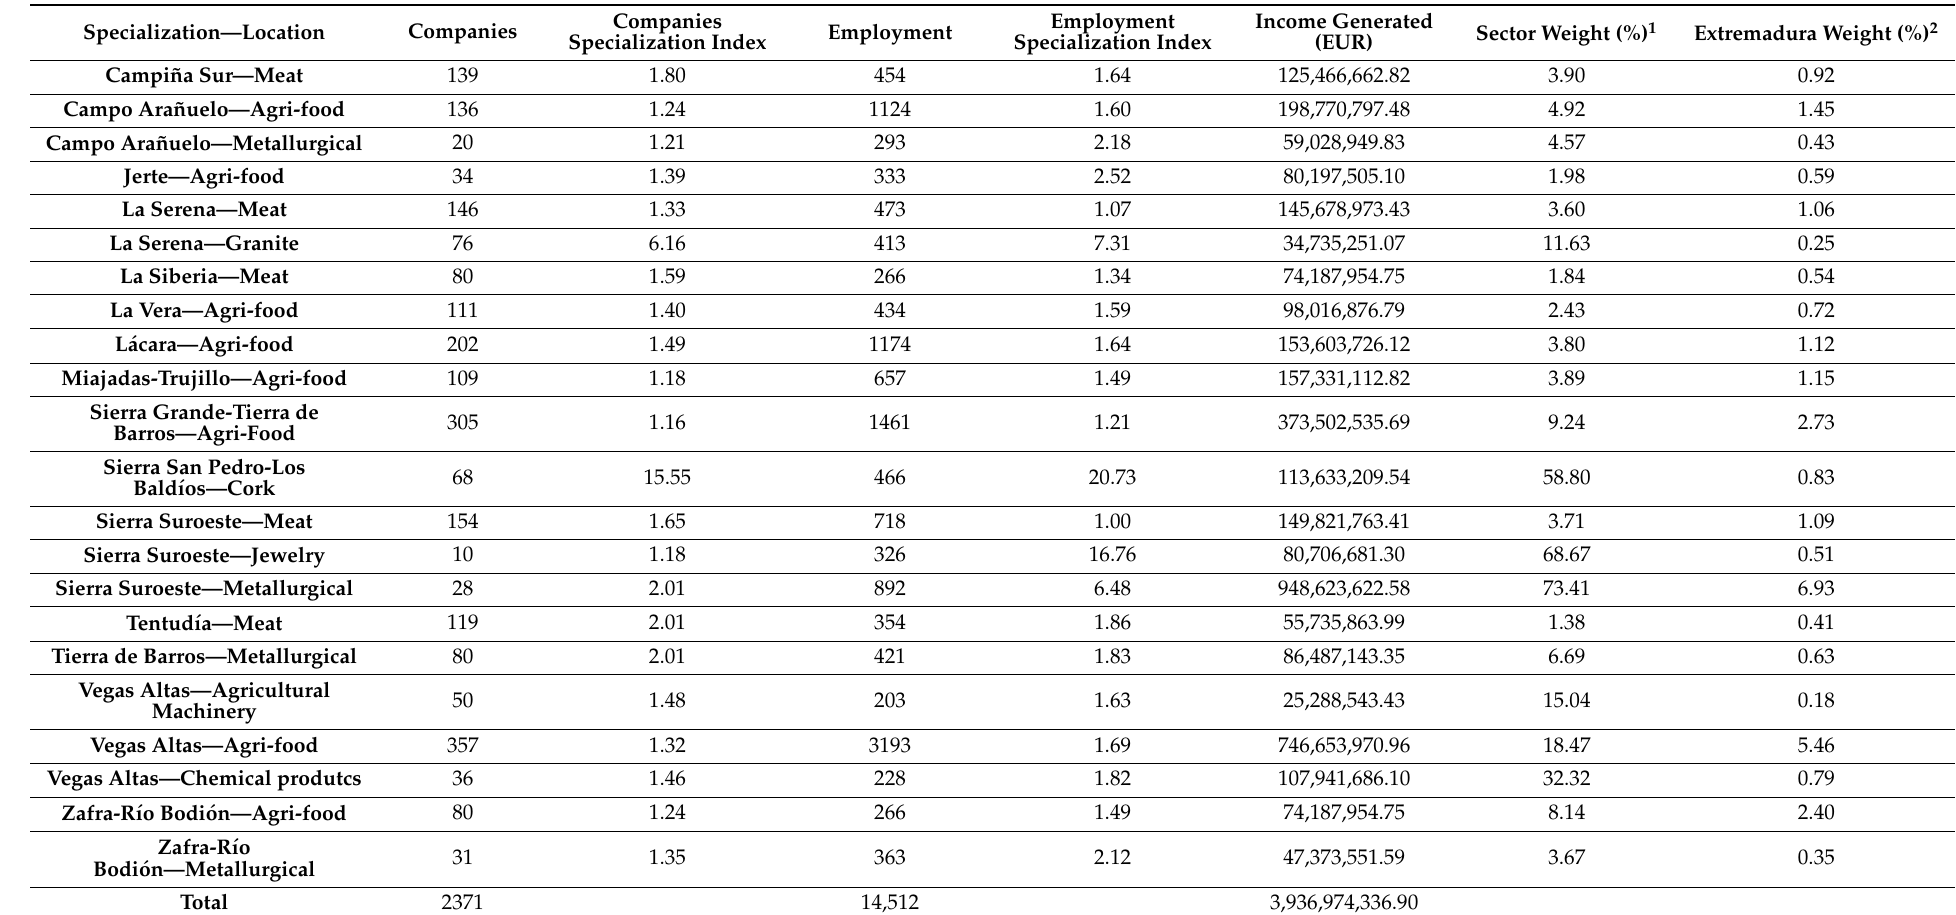
Table 5. Rural districts (LPS) in